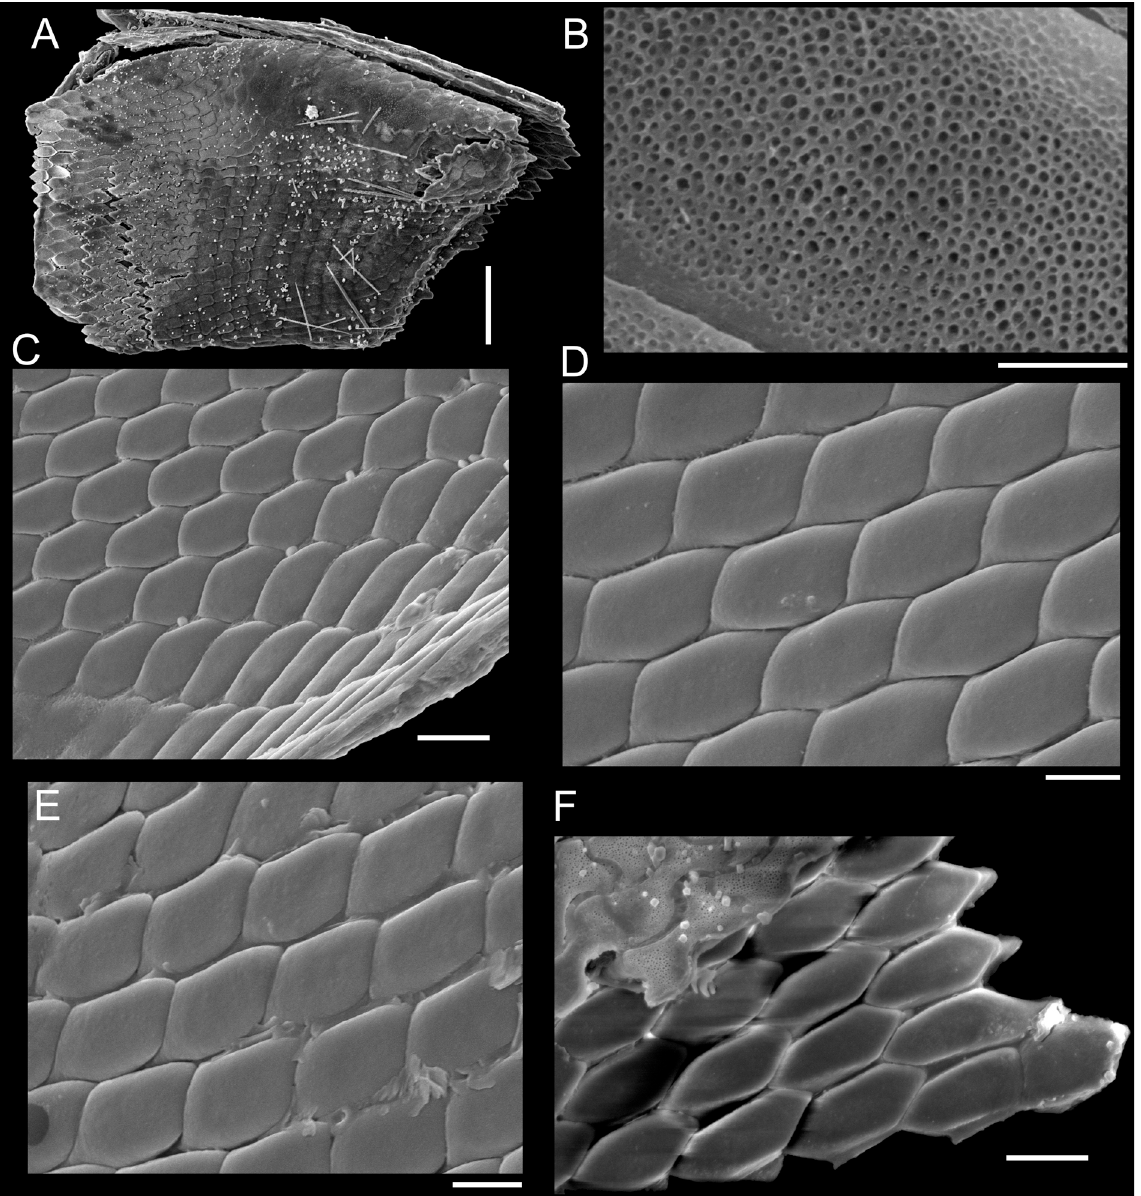
Fig. 15. Monophorus olivaceus (Dall, 1889). A–B, F . MNRJ 34240. C–E . MNRJ 35075. A–F . Jaw, outer (A–B) and inner (C–F) sides. Scale bars: A = 50 µm; B = 2 µm; C, F = 10 µm; D–E = 5